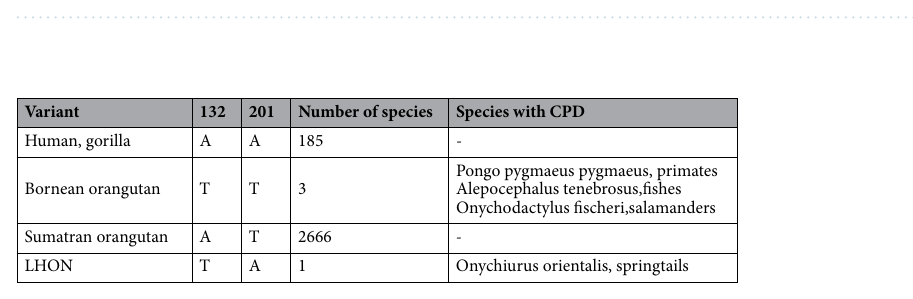
Table 4. Human LHON variants in non-human species. Variants that are considered in detail below are shown in bold.